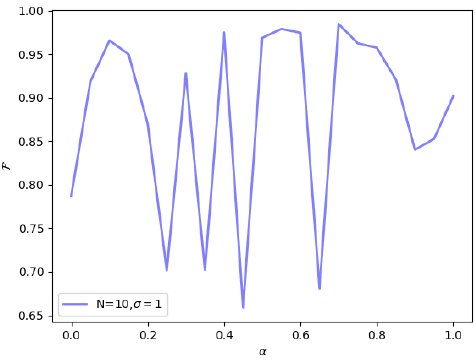
Figure 8. N = 10, fidelity of 2-qubit Wermer